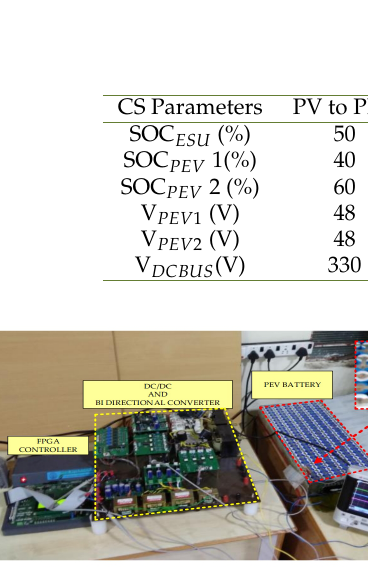
Fig. 8. Experimental